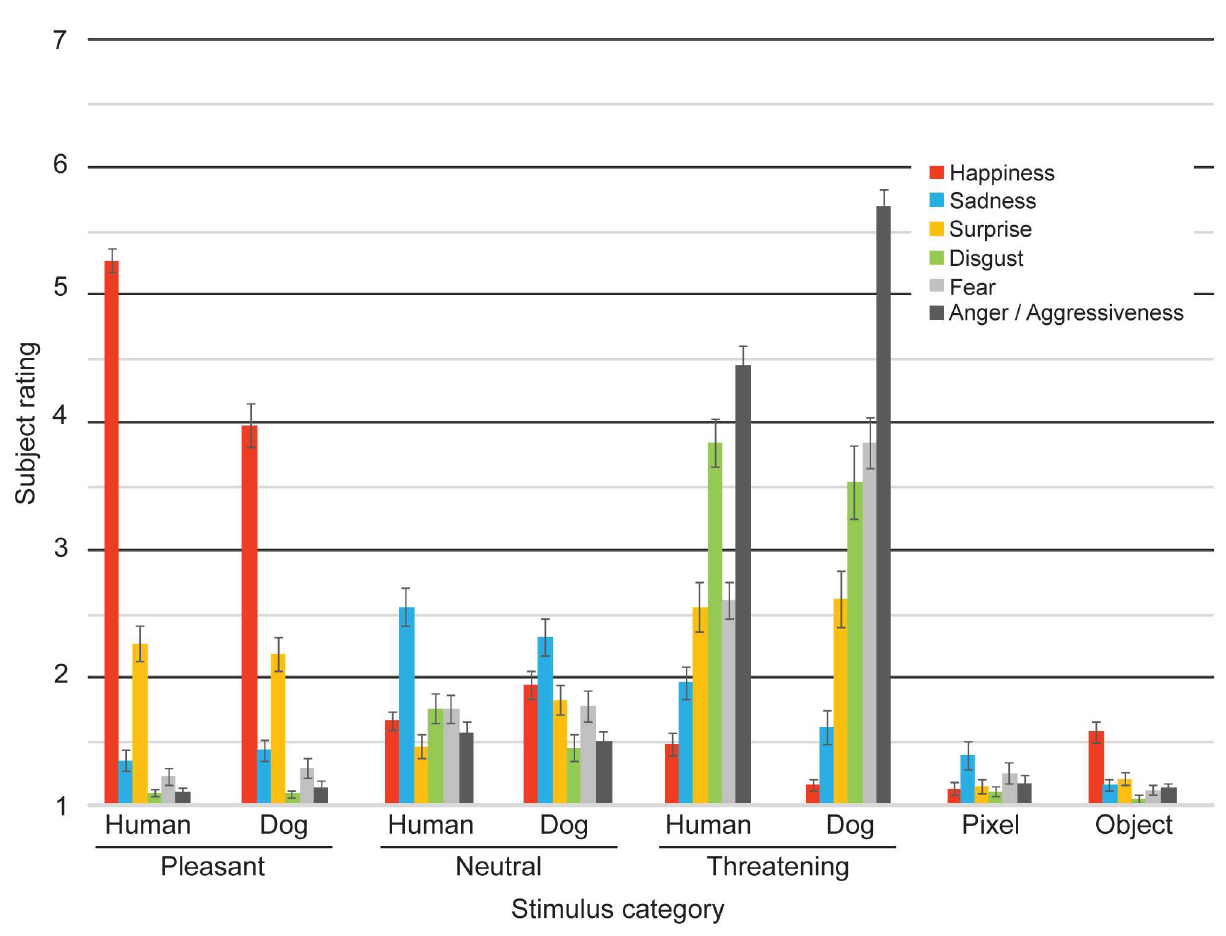
Fig 2. Discreteemotion ratings. Subject ratings of happiness,sadness, surprise, disgust, fear and anger / aggressiveness (on a scale from 1 (min) to 7 (max) for all the stimulus categories (PleasantHumans, Pleasant Dogs, NeutralHumans, NeutralDogs, ThreateningHumans, Threatening Dogs, Pixel, and Object (Mean ±